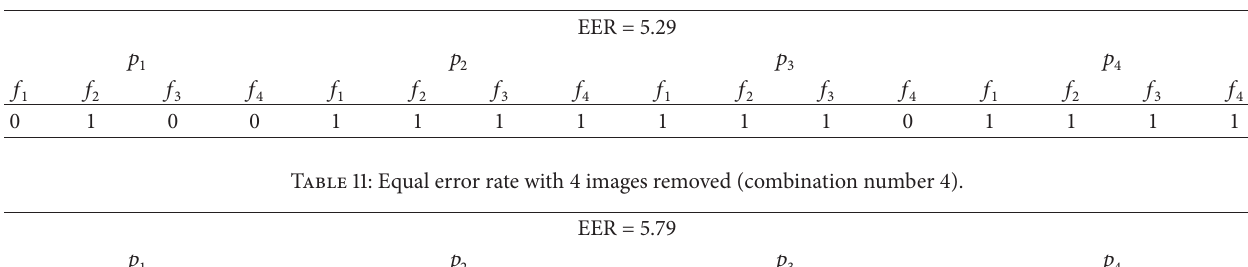
Table 10: Equal error rate with 4 images removed (combination number 3).